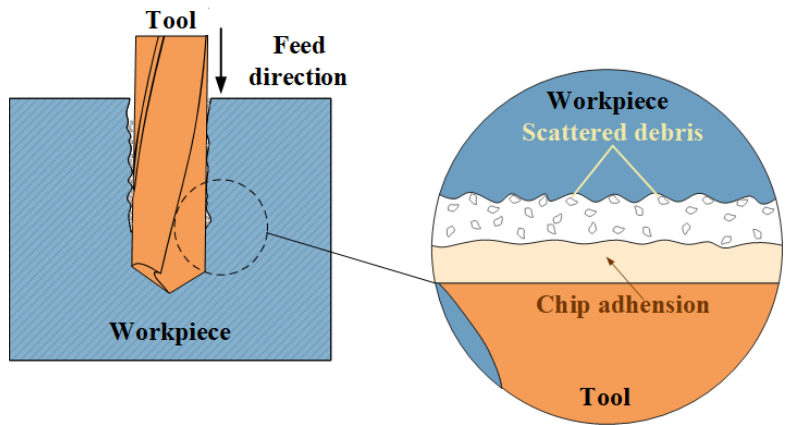
Figure 11. Mechanism diagram of the effect of chip adhesion on surface roughness.